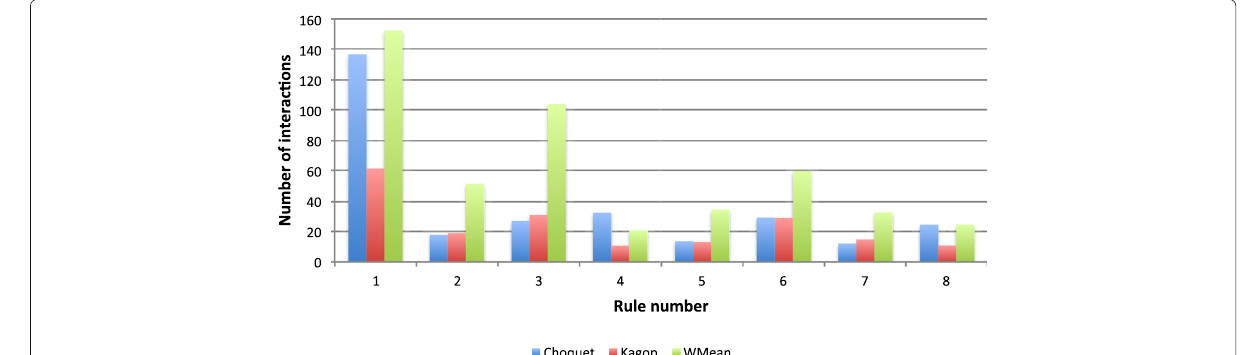
Fig. 12 Number of interactions needed to cover the user privacy preferences model